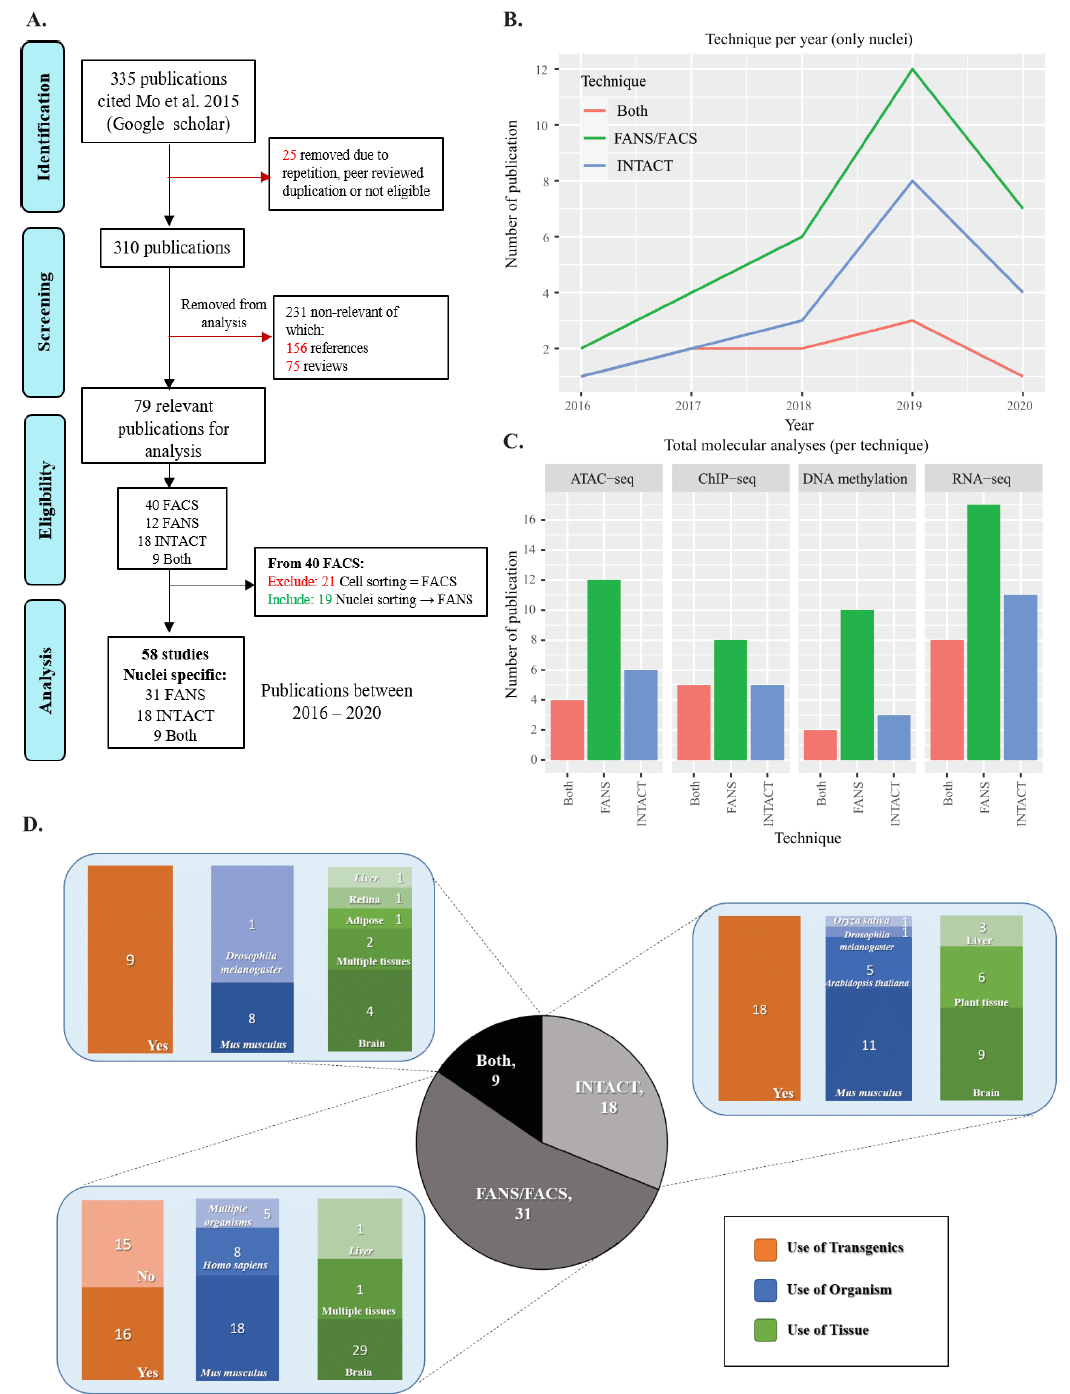
Figure 1. Literature review of Mo et al.’s (2015) citations: ( A ) literature review workflow for assessing the usage of INTACT and FANS; ( B ) publication trend of individual techniques per year; ( C ) use of subsequent sequencing techniques per year of publications for INTACT, FANS or both; ( D ) overview of the use of transgenics, organism, and tissue per technique (see Supplementary Materials Table S1 for additional